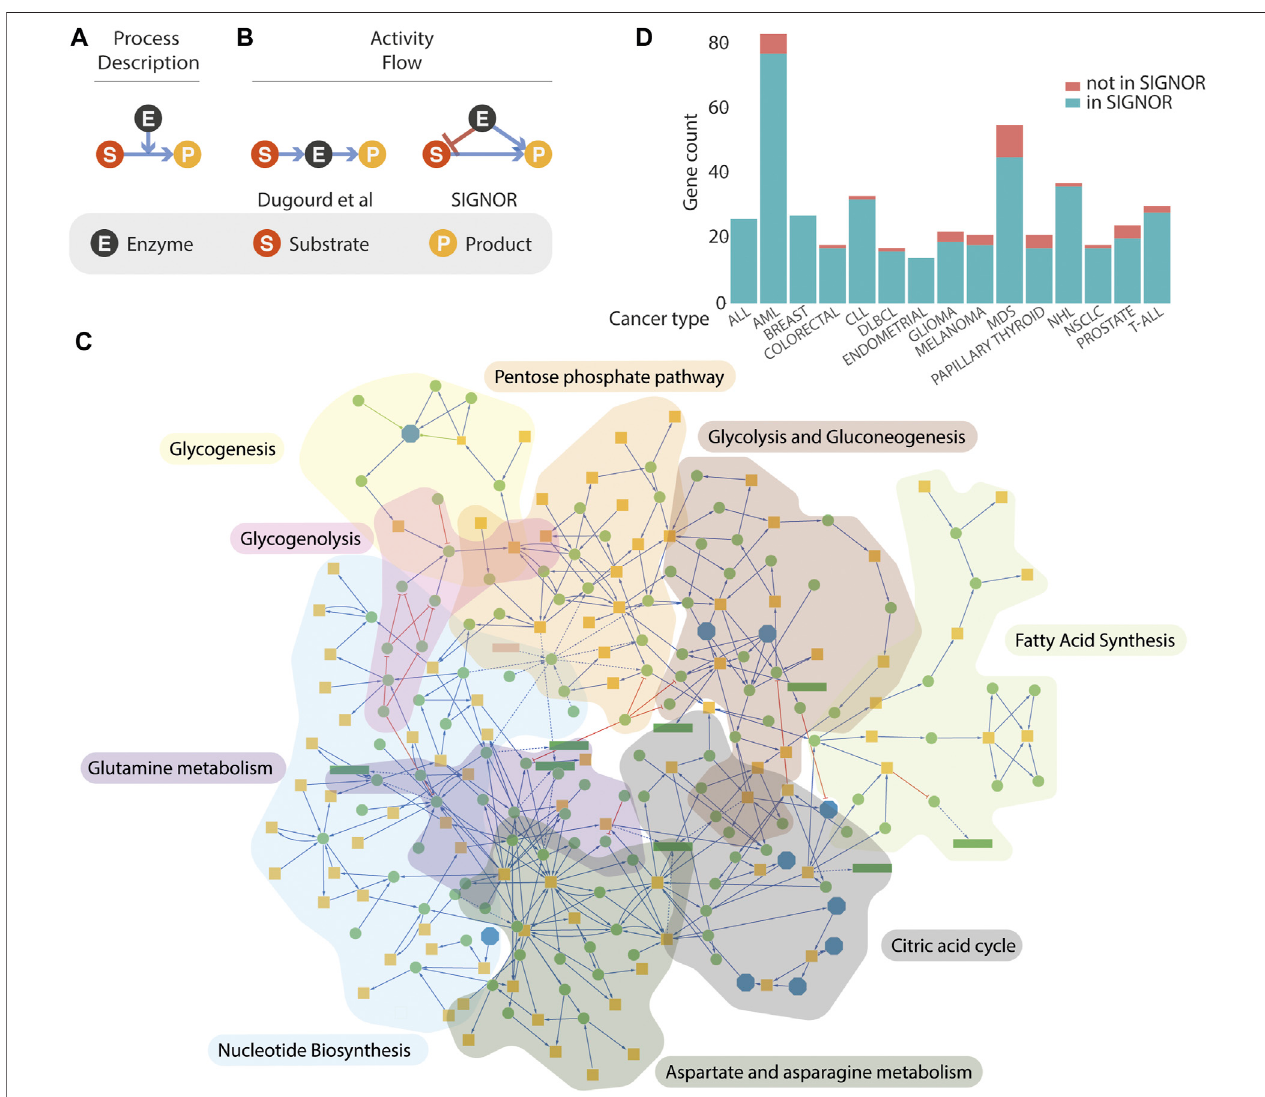
FIGURE 1 | Representation of metabolism in SIGNOR. (A,B) three models that can be used to represent enzymatic reactions. See text for details. (C) Graph representations of the metabolic pathways annotated in the SIGNOR databases. Orange square represents small organic molecules that participate in the enzymatic interactions, Green circles are enzymes that catalyse the reactions or other proteins modulating their activities. Reactions are arbitrarily organized into nine metabolic pathways that are identi fi ed by a different background colour. (D) Coverage in the SIGNOR database of the cancer driver genes annotated in the Cancer Gene Census. The height of each green bar isproportional to the number of cancer genes in the SIGNOR human network that are annotated to 15speci fi ctumour types. The fraction of cancer genes for which we couldn ’ t fi nd causal information is in orange. T-ALL, T cell acute lymphoblastic leukaemia; NSCLC, Non-small-cell lung cancer; NHL, non-Hodgkin lymphoma; MDS, myelodysplastic syndrome; DLBCL, diffuse large B-cell lymphoma; CLL, chronic lymphocytic leukaemia; AML, acute myeloid leukaemia; ALL, acute lymphocytic leukaemia.